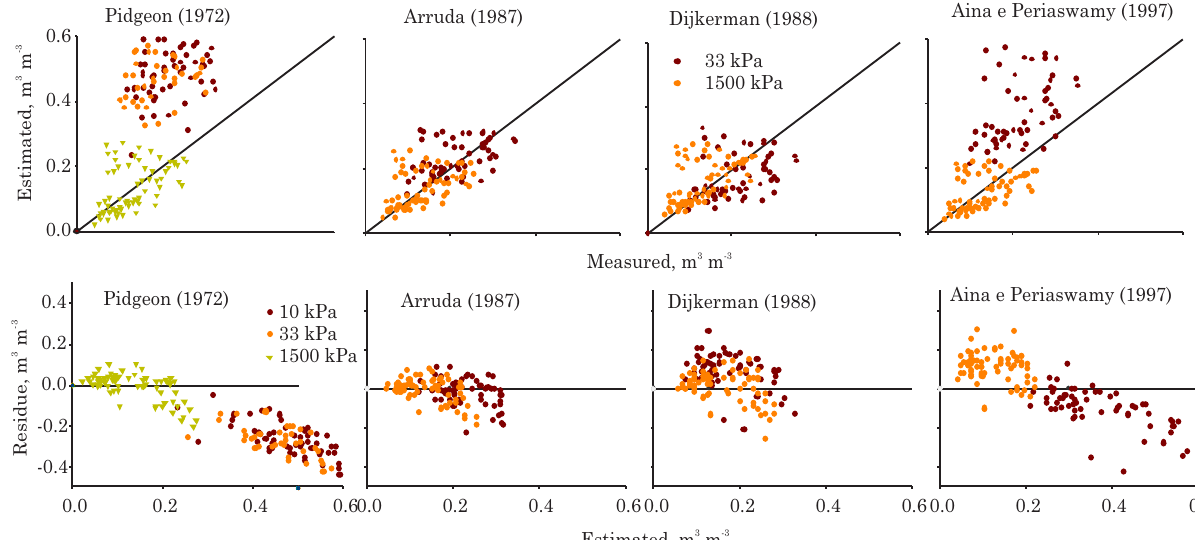
Figure 7. Estimated vs measured gravimetric water content, and estimation residues for the point PTFs tested for all depths (n =